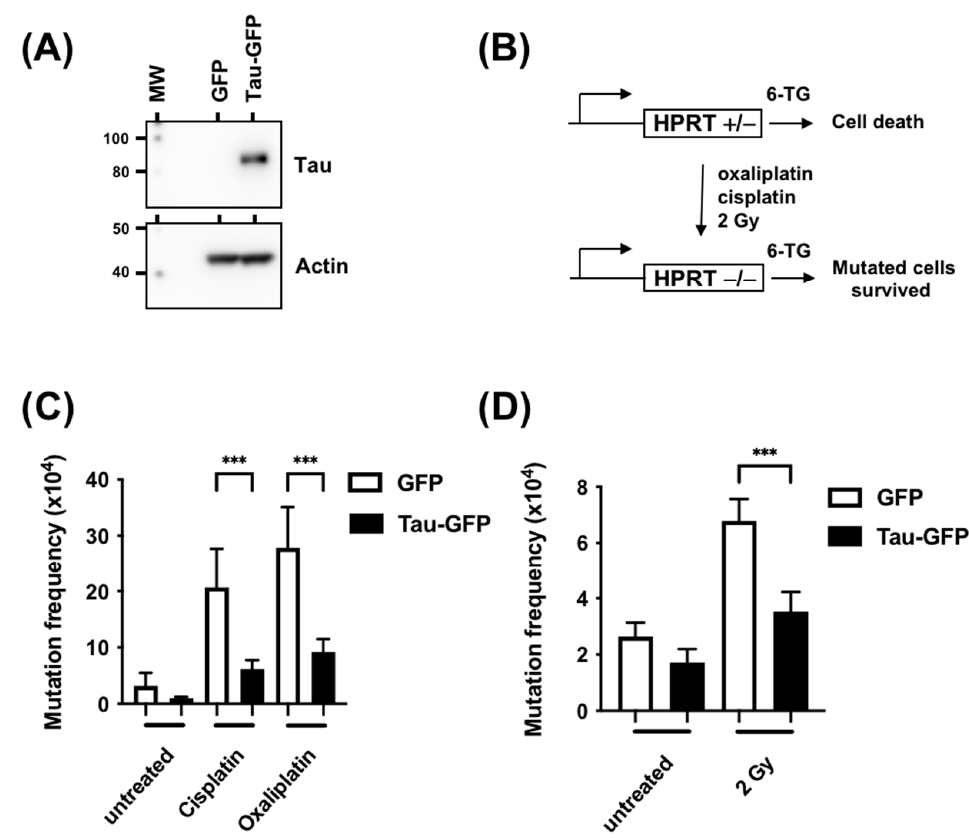
Figure 3. Tau inhibition increases mutation frequency measured by the Hprt test. ( A ) Western blot analysis of Tau expression in CHO-GFP and CHO-Tau-GFP stable clones using anti-Tau and anti-actin antibodies. ( B ) Schematic representation of the HPRT test in CHO cells. ( C ) CHO cells were stably transfected with plasmids coding for GFP or GFP-Tau and treated with cisplatin (10 μ M, 2 h) or oxaliplatin (20 μ M, 2 h). Mutation frequency was measured as the number of colony/number of cells seeded X efficiency of plating. ( D ) CHO cells were stably transfected with plasmids coding for GFP or GFP-Tau and treated with X-rays (4 Gy). Mutation frequency was determined as described in B. Data are mean ± SD *** p < 0.001.